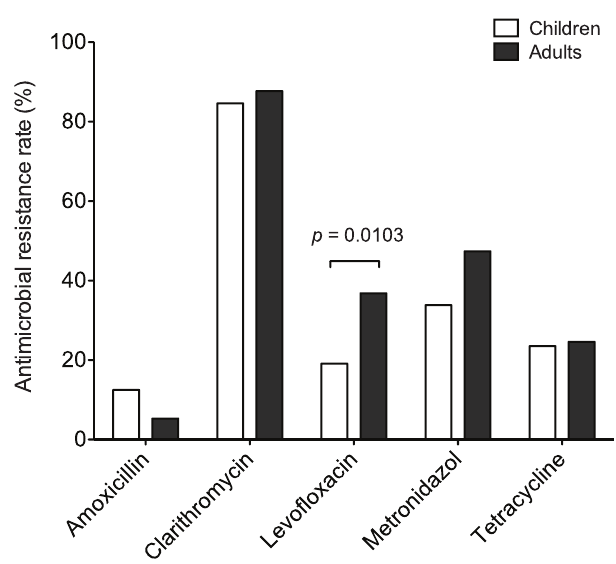
Figure 1. Antimicrobial resistance rate of Helicobacter pylori isolates from Vietnamese children and adults. The graph displays the resistance rate of amoxicillin, clarithromycin, levofloxacin, metronidazole, and tetracycline in both children and adults. Among the antimicrobial agents, clinical isolates resistant to levofloxacin is significantly higher ( p = 0.0103) in adults than in